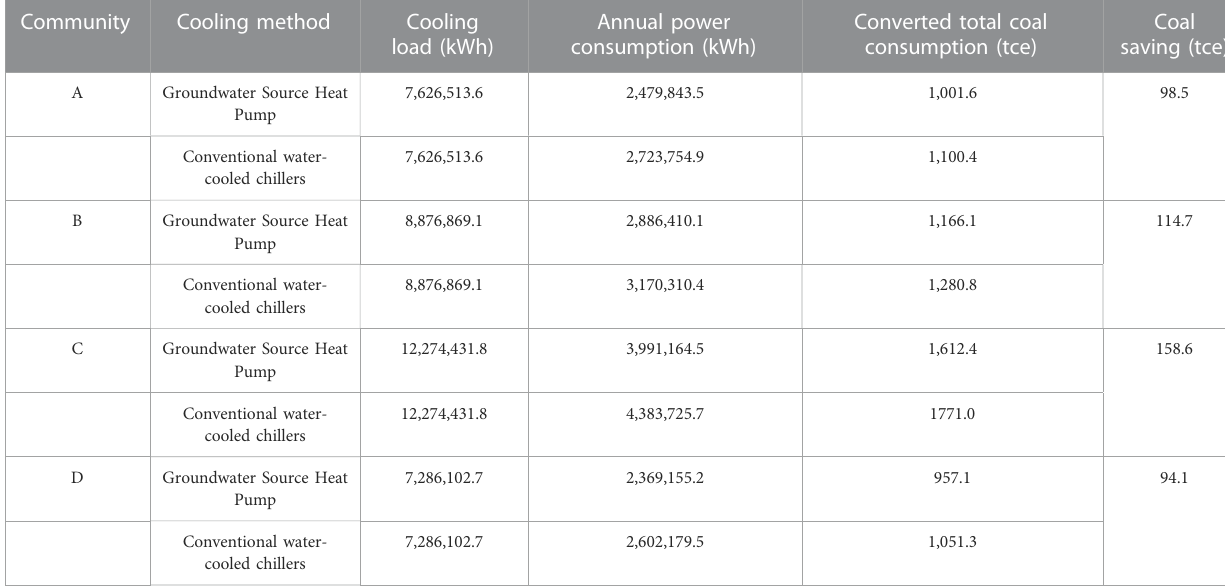
TABLE 9 Conventional energy substitution calculation table.